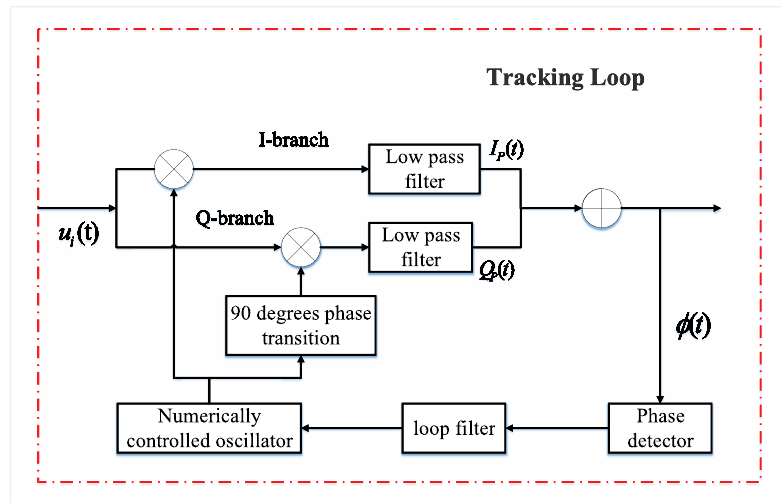
Figure 1. Block diagrams of the phase lock loop in the tracking of BeiDou reflected